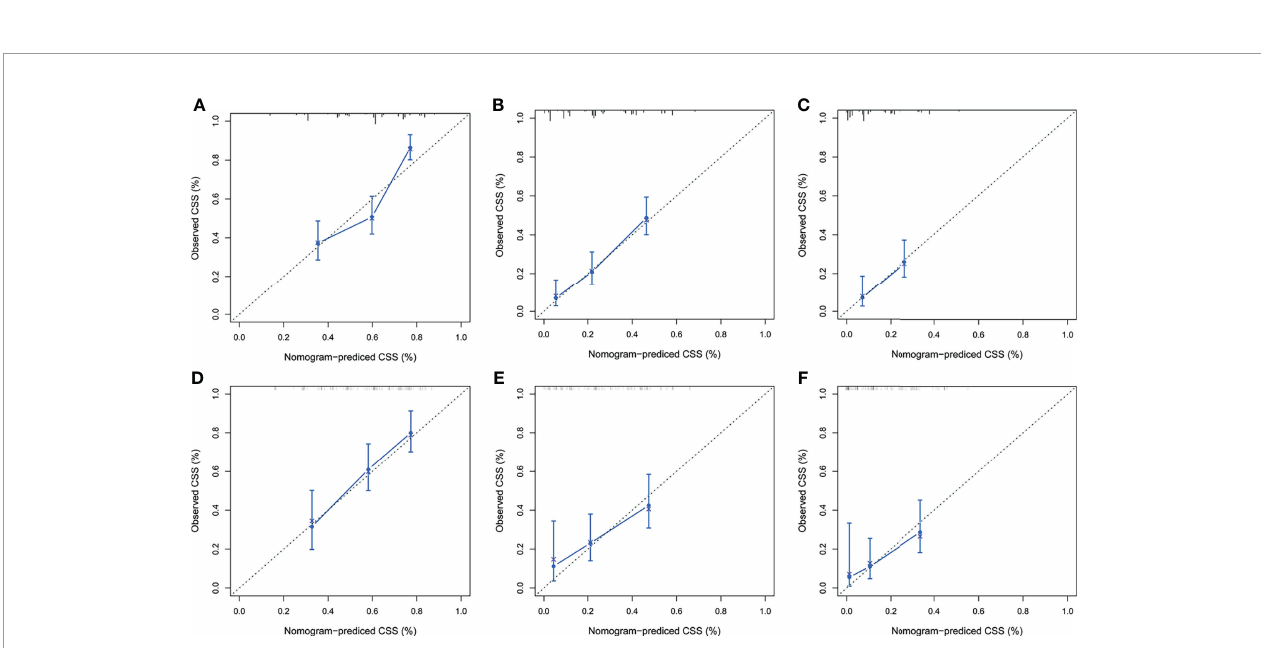
FIGURE 9 | The calibration curves of the prognostic nomogram for predicting 1-year (A) , 3-year (B) , and 5-year (C) CSS in the training set. Calibration curves of the prognostic nomogram for predicting 1-year (D) , 3-year (E) , and 5-year (F) CSS in the validation set. CSS, cancer-speci fi c survival. ROC, receiver operating curve; OS, Overall